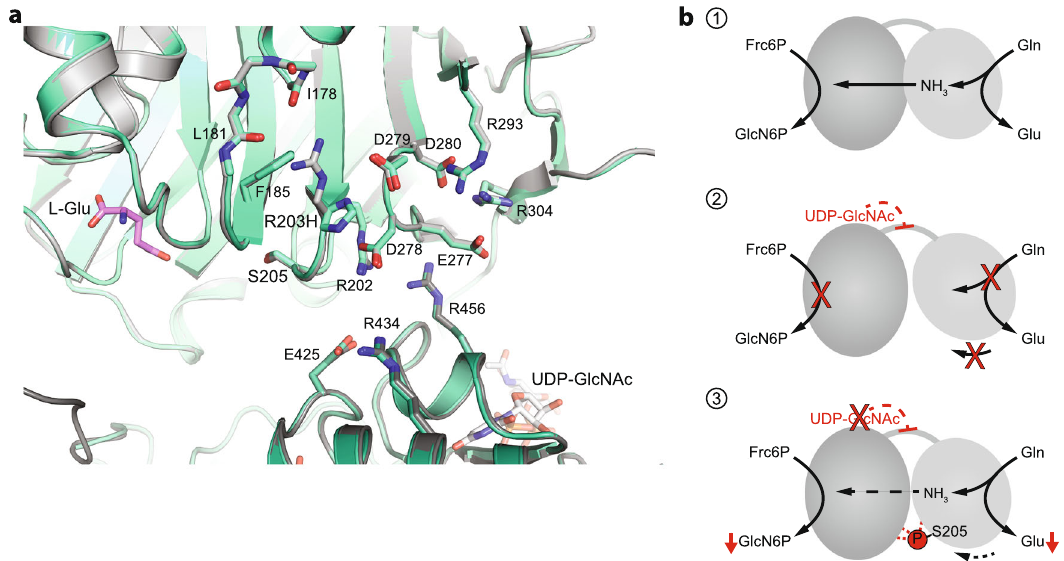
Fig. 6 Altered domain interactions affect GFAT-1 activity. a Superposition of the structures of wild type (gray) and R203H (green – cyan) GFAT-1 in cartoon representation. L -Glu (violet sticks) and UDP-GlcNAc (white sticks) are highlighted. Ser205, the R203H substitution, and residues that might form salt bridges in close proximity to the mutation are highlighted with sticks. b Schematic models of one GFAT monomer. (1) Catalysis: L -Gln is hydrolyzed to L -Glu and the released ammonia is shuttled through an ammonia channel from the glutaminase to the isomerase domain. (2) UDP-GlcNAc inhibition: UDP- GlcNAc binds to the isomerase domain, interacts with the interdomain linker, and inhibits the glutaminase function and thereby the GlcN6P production. (3) Ser205 phosphorylation: Upon phosphorylation, the catalytic activity is reduced and the UDP-GlcNAc inhibition is